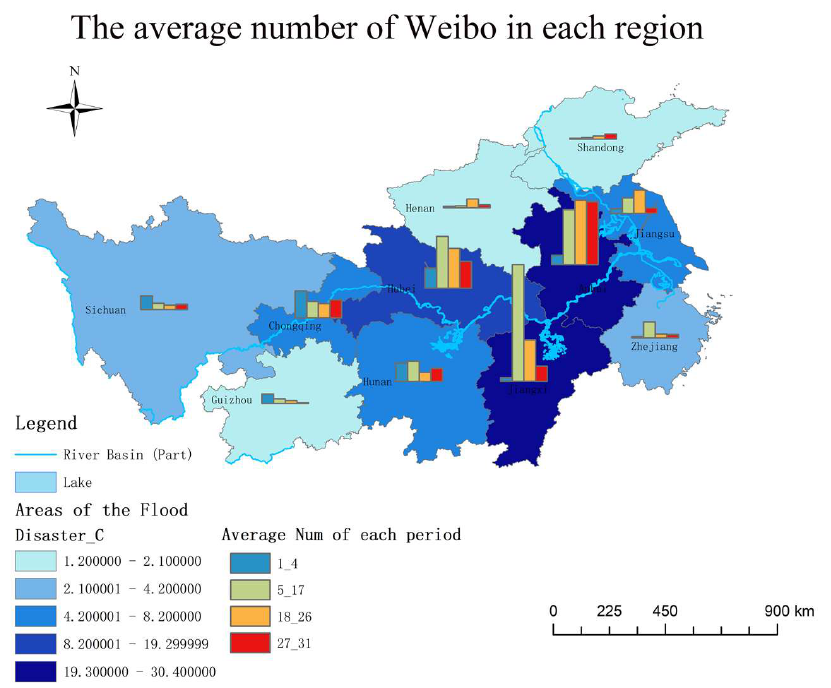
Figure 17. The average number of Weibos in each region.